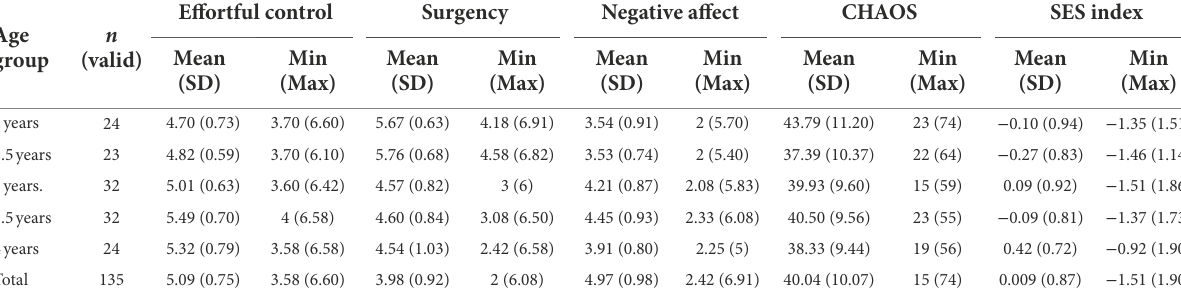
TABLE 4 Descriptive statistics for questionnaire measures at Time 1.